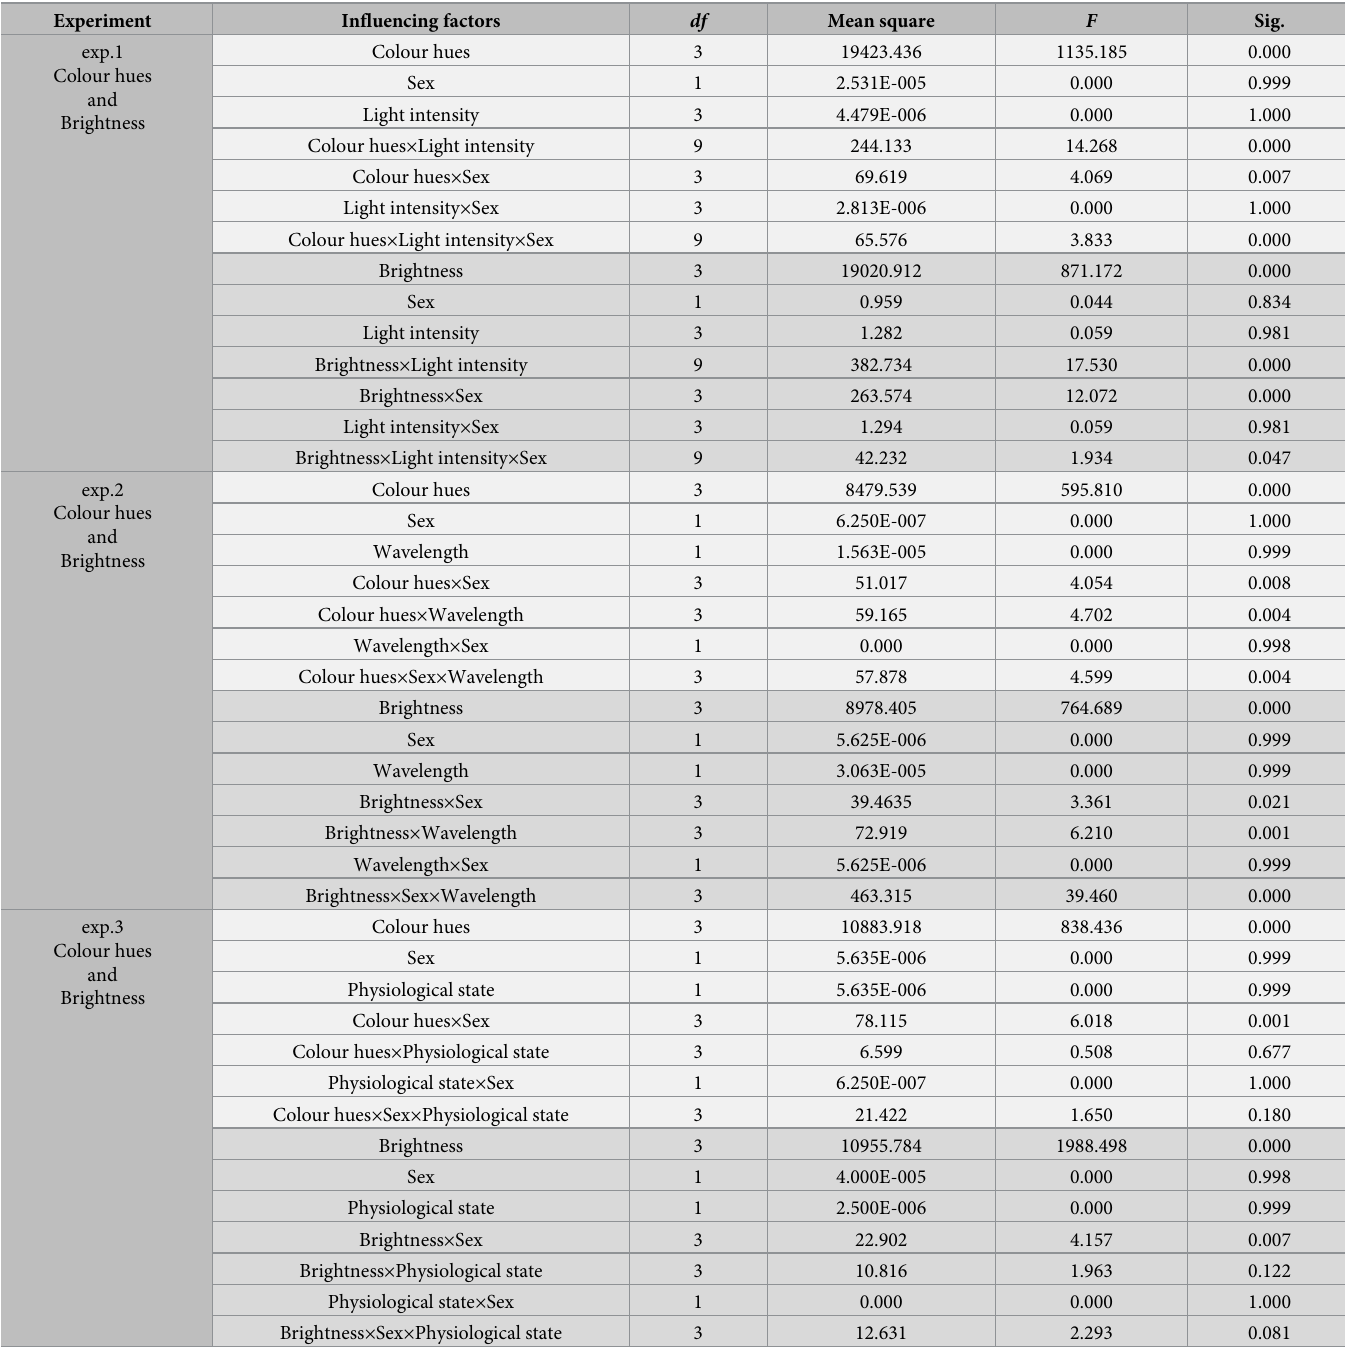
Table 2. Variance analysis of the response of Bradysia odoriphaga to colour hues and brightness under different light intensities and wavelengths.